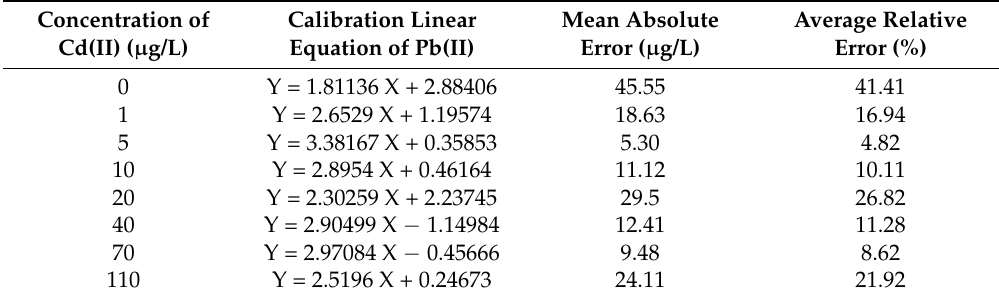
Table 2. Prediction results of 110 µ g/L Pb(II) in the presence of 5 µ g/L Cd(II) by linear equations. Concentration